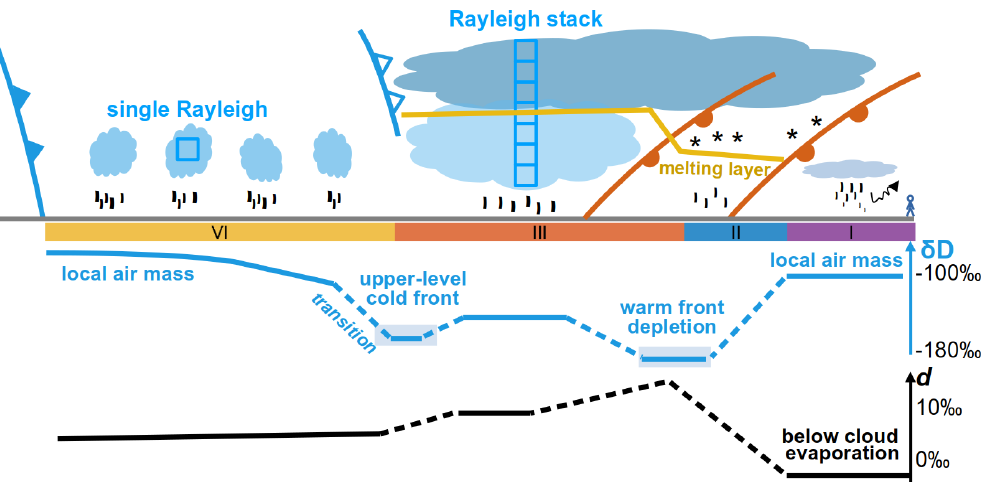
Figure 9. Weather diagram for the land-falling AR at Bergen on 7 December 2016. δ D and d -excess lines represent the evolution of isotope composition of equilibrium vapour from surface precipitation. Precipitation periods (I, II, III, and IV) are indicated with colour bars at the bottom. Note that the timeline is from right to